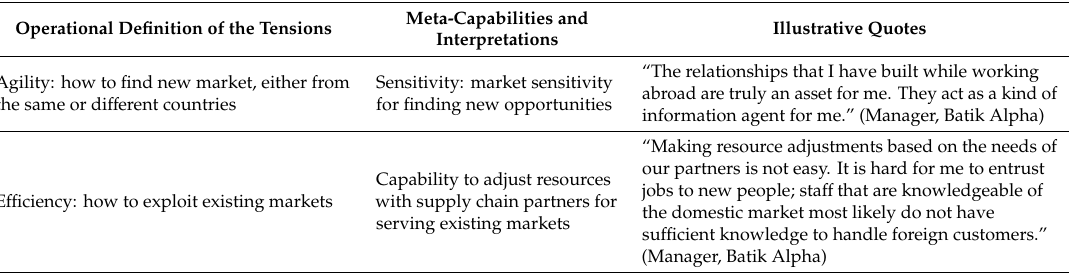
Table 4. Tension between exploring new markets or exploiting existing